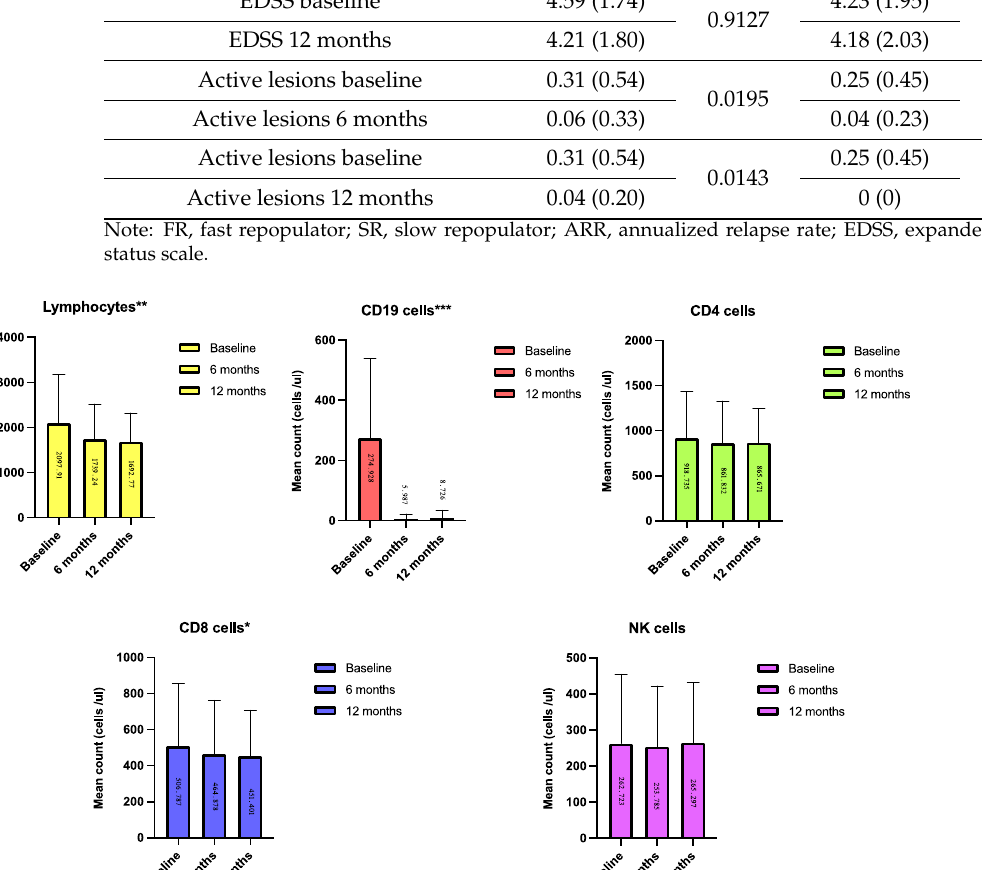
Table 3. Ocrelizumab effectiveness in patients with fast and slow repopulation rate at six months. Data are reported using mean ± standard deviation (sd).